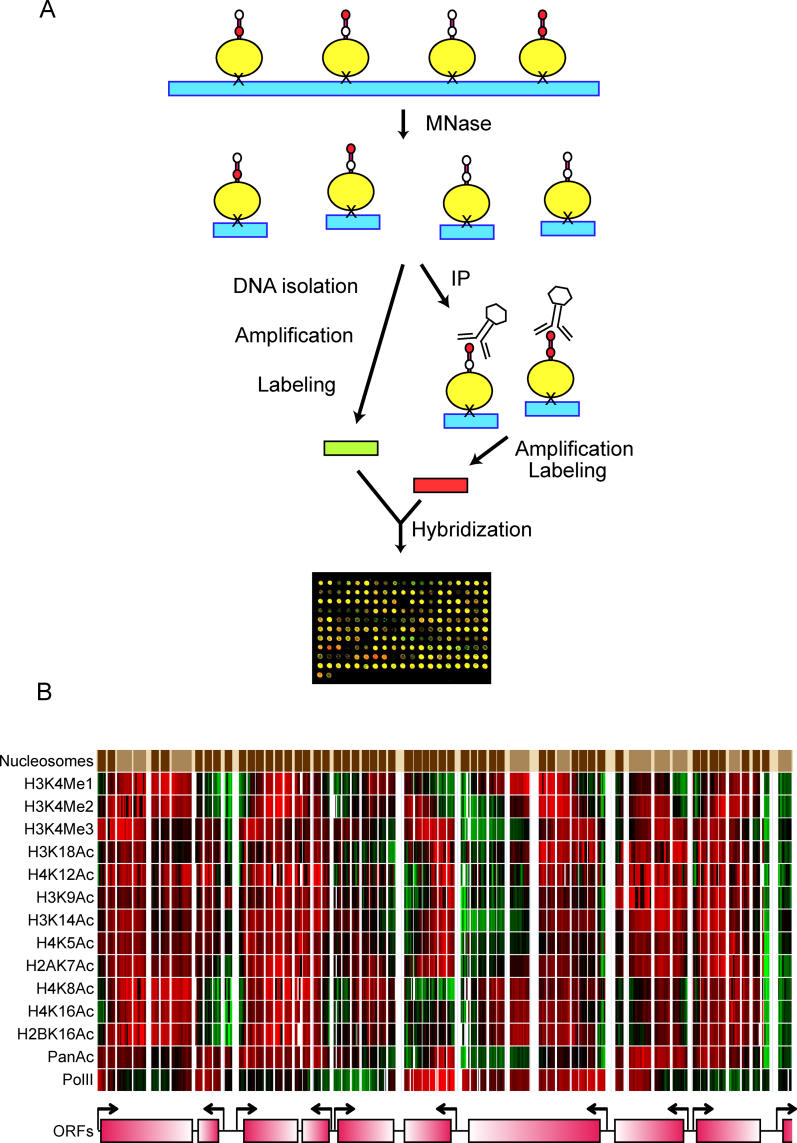
Overview(A) Nucleosomes are first cross-linked to DNA using formaldehyde. Cross-linked chromatin is digested to mononucleosomes with micrococcal nuclease. Mononucleosomal digests are immunoprecipitated using an antibody specific to a particular histone modification, and immunoprecipitated DNA is isolated and labelled with Cy5. DNA is also isolated from the same nuclease titration step prior to immunoprecipitation, labelled with Cy3, and mixed with Cy5-labeled immunoprecipitated DNA. Labelled DNA is then hybridized to a tiled microarray covering half a megabase of yeast genome.(B) Example of raw data. Data are shown for all modifications tested, along with PolII data. Red (green) indicates enrichment (depletion), while grey indicates missing data. Data from probes found in linker regions are not shown. Each row represents median data from multiple replicates with one antibody, as indicated (PanAc refers to a nonspecific antibody to acetyl-lysine, which we used to measure bulk acetylation). “Nucleosomes” shows positions of nucleosomes previously described [29], with dark brown for well-positioned nucleosomes, very light brown for linkers, and intermediate brown for delocalized nucleosomes. “ORFs” shows locations of annotated genes. Data shown are for Chromosome III coordinates 58,900 to 72,100.